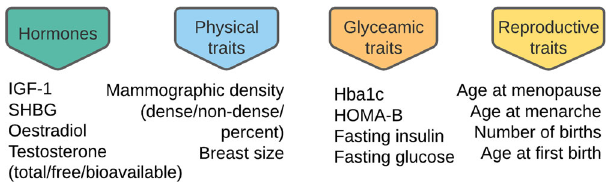
Fig. 1 Potential mediator groups. Traits that may be in fl uenced by childhood adiposity to affect breast